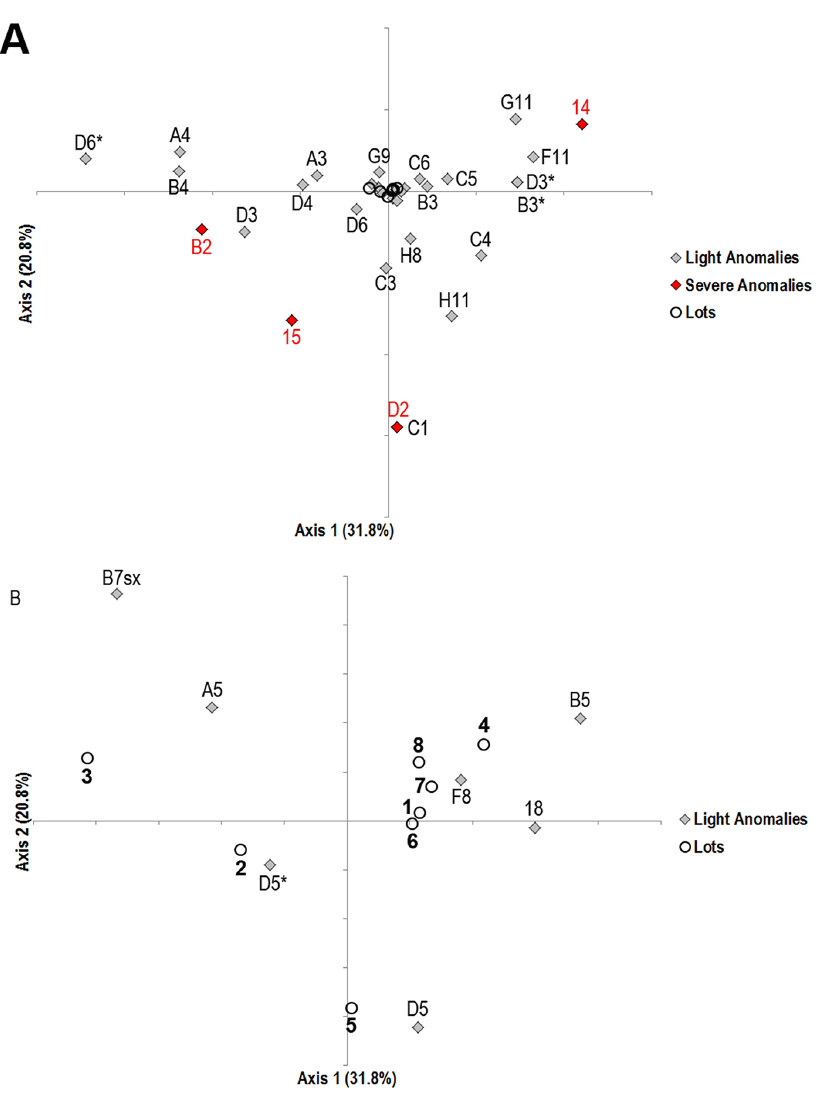
Figure 3. Correspondence Analysis ordination plot. CA (A)ordination of anomalies and lots (axis 1 vs 2). Red codes highlight commercially severe anomalies; (B) magnification of (A), in order to visualize lot arrangement more clearly.